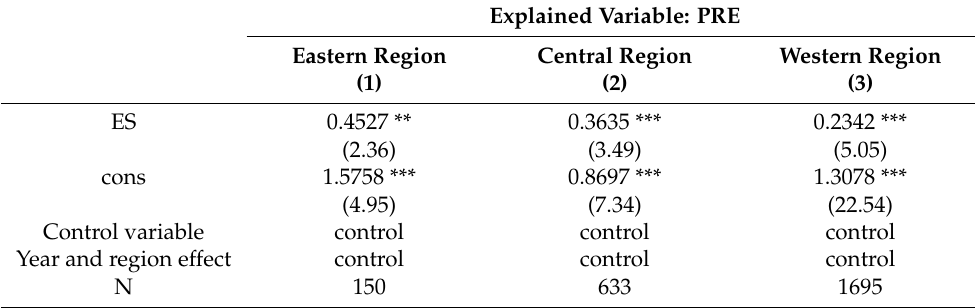
Table 6. The impact of ES on the PRE in state poverty counties: different regions analysis. Explained Variable: